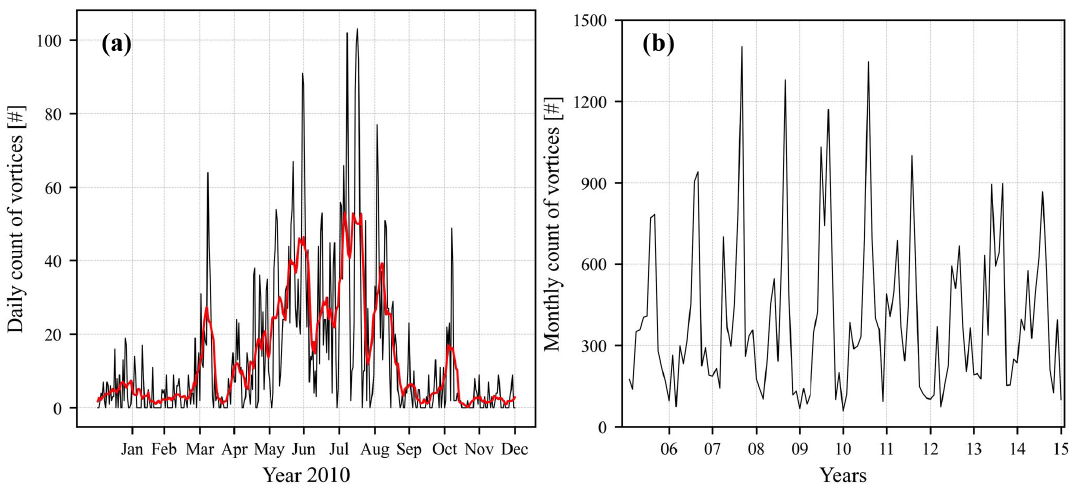
Figure 15. (a) Daily count of identified vortices in CRS1 in 2010 in black and its 10d moving average in red. (b) Monthly count of identified vortices in CRS1 from 2006 to 2015.